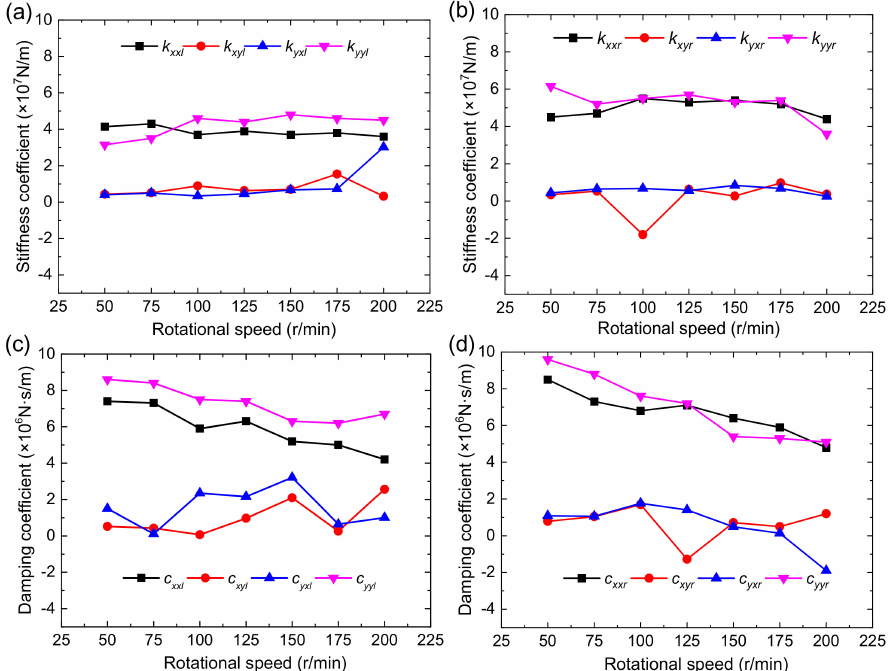
Figure 15. The relationship between the dynamic characteristic coefficient and rotational speed: ( a ) Stiffness coefficient of left bearing unit; ( b ) stiffness coefficient of right bearing unit; ( c ) damping coefficient of left bearing unit; ( d ) damping coefficient of right bearing